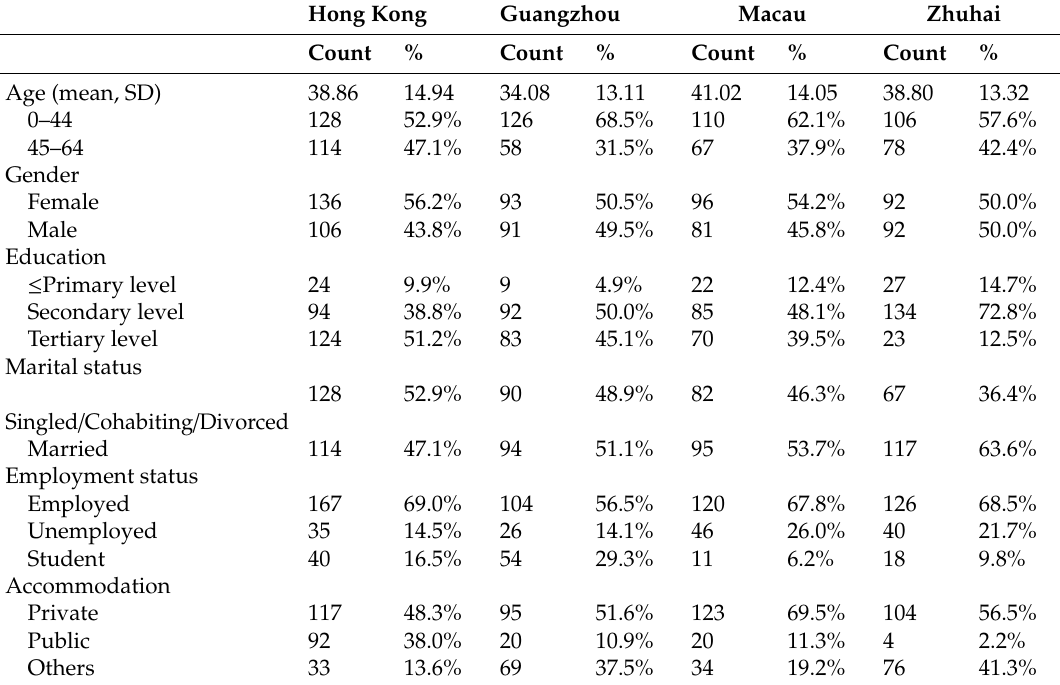
Table 1. Demographic data of the participants by city.